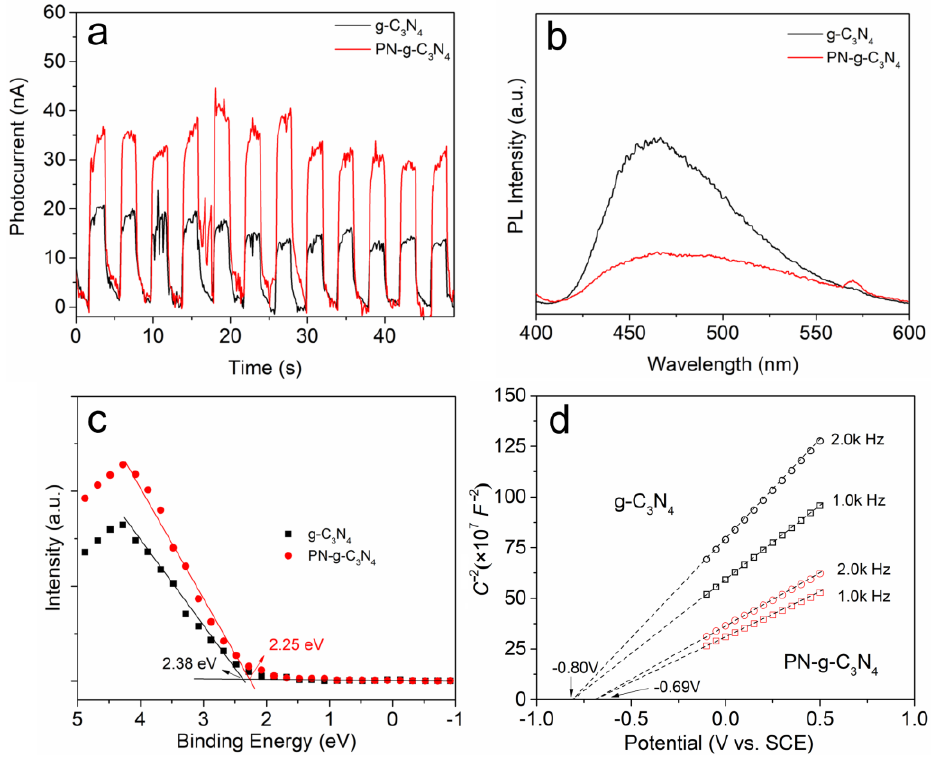
Figure 8. Transient photocurrent response ( a ), PL spectra ( b ), Valence band XPS spectra ( c ), and the Mott–Schottky plot ( d ) of g-C 3 N 4 and PN-g-C 3 N 4 samples.